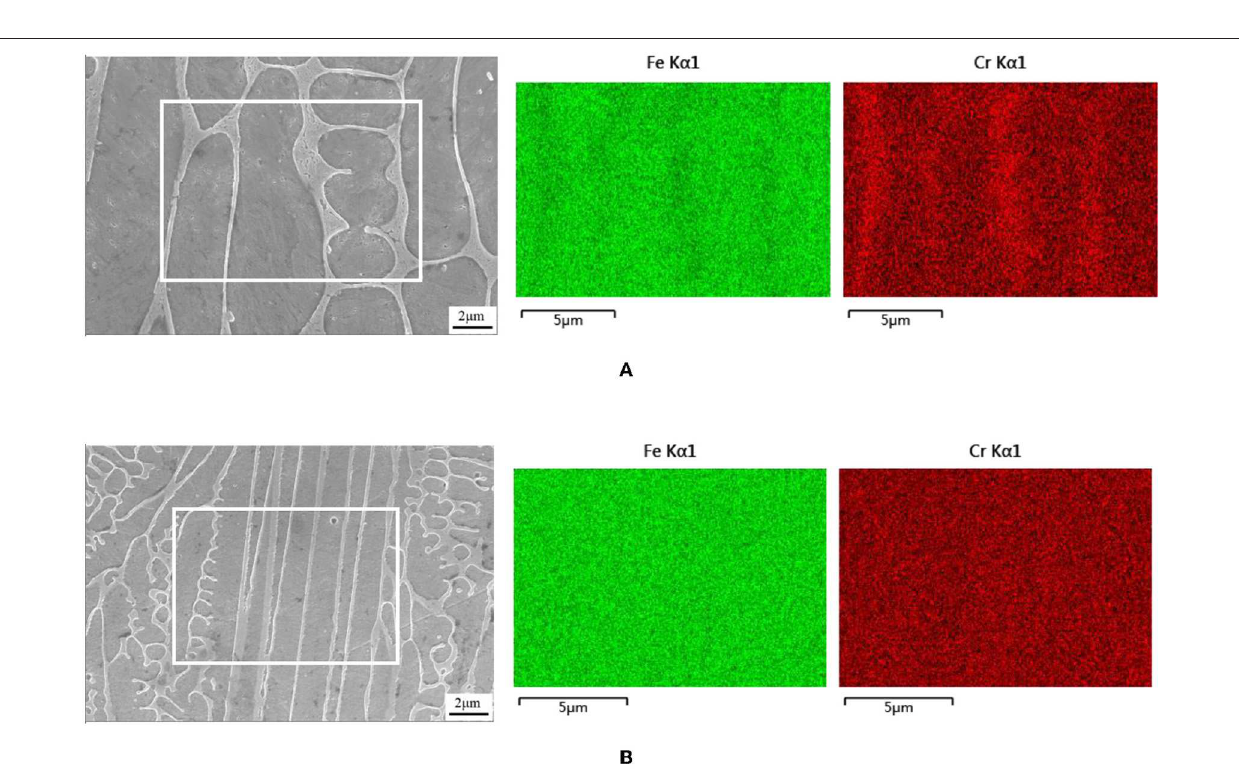
Frontiers in Materials |